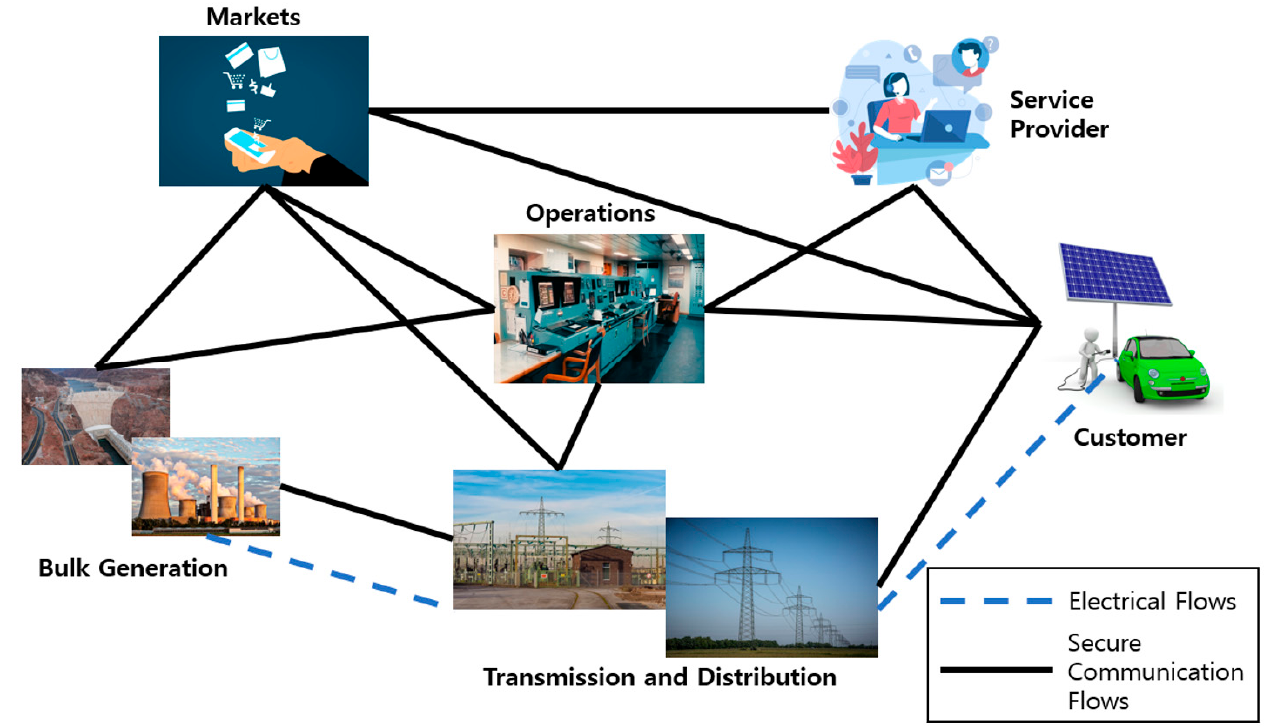
Figure 1. Interactive Domain on Smart Grid.